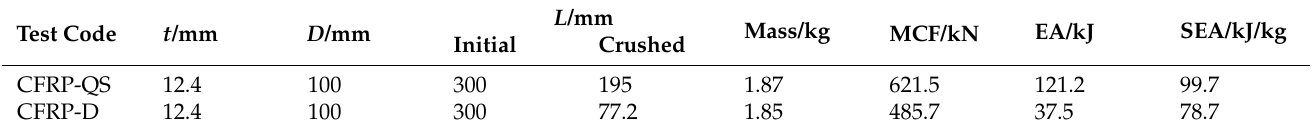
Table 1. Geometrical and crashworthiness parameters for circular CFRP